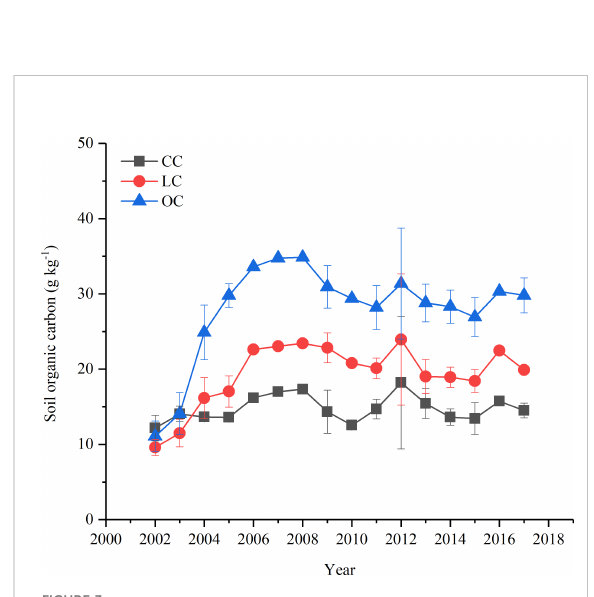
FIGURE 3 Soil organic carbon content with the three different cultivation methods from 2002 to